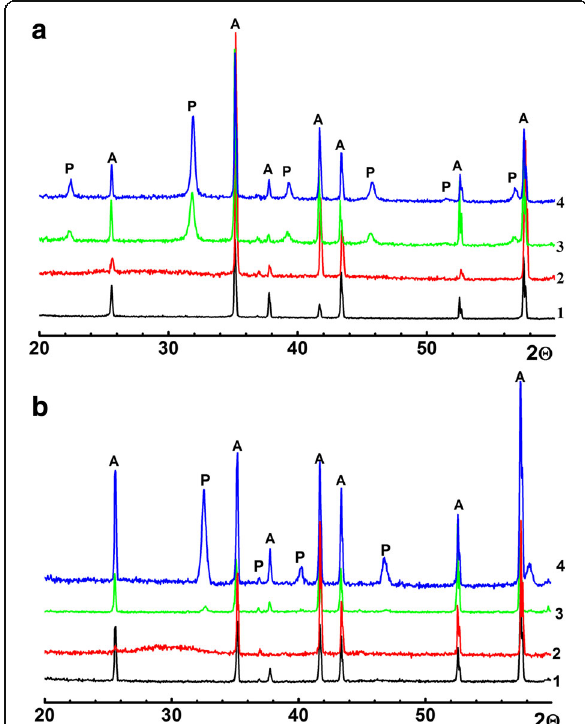
Fig. 4 X-ray diffraction patterns of α -Al2O3 substrate (1) and the thin films after heat treatment at different temperatures. a BST: 2 — 500, 3 — 600, and 4 — 900 °C. b LLT: 2 — 500, 3 — 700, and 4 — 900 °C